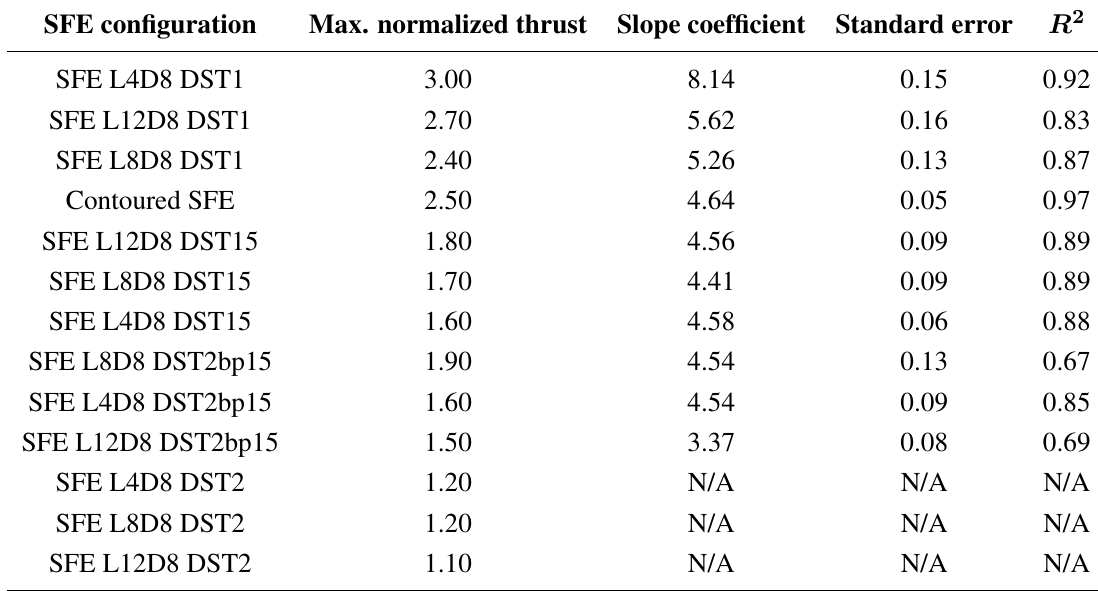
Table 1. SFE thrust linear regression